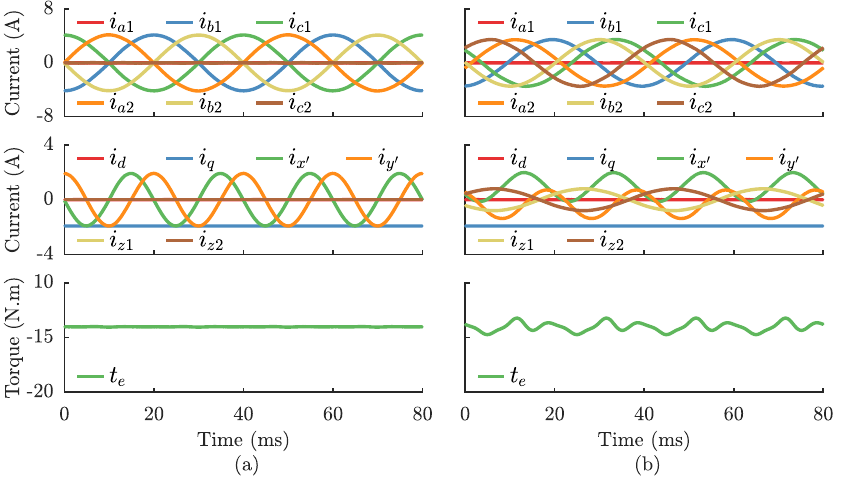
Figure 6. Simulation results for the six-phase drive under fault-tolerant mode due to an OPF in phase a 1, operating at 750 rpm, 50% load level, and under: ( a ) 2N configuration; ( b ) 1N configuration. Table 2. Simulation results: current THD for fault-tolerant mode due to an OPF in phase a 1 at 750 rpm.